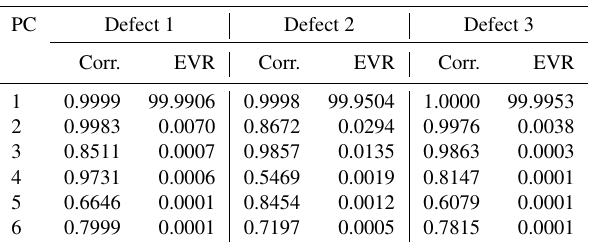
Table 4. Correlation coefficients (Corr.) of PC scores of GEMS and ML radiances and the EVR of GEMS radiances for each target re- gion in Figs. 8–10 excepting bad-pixel